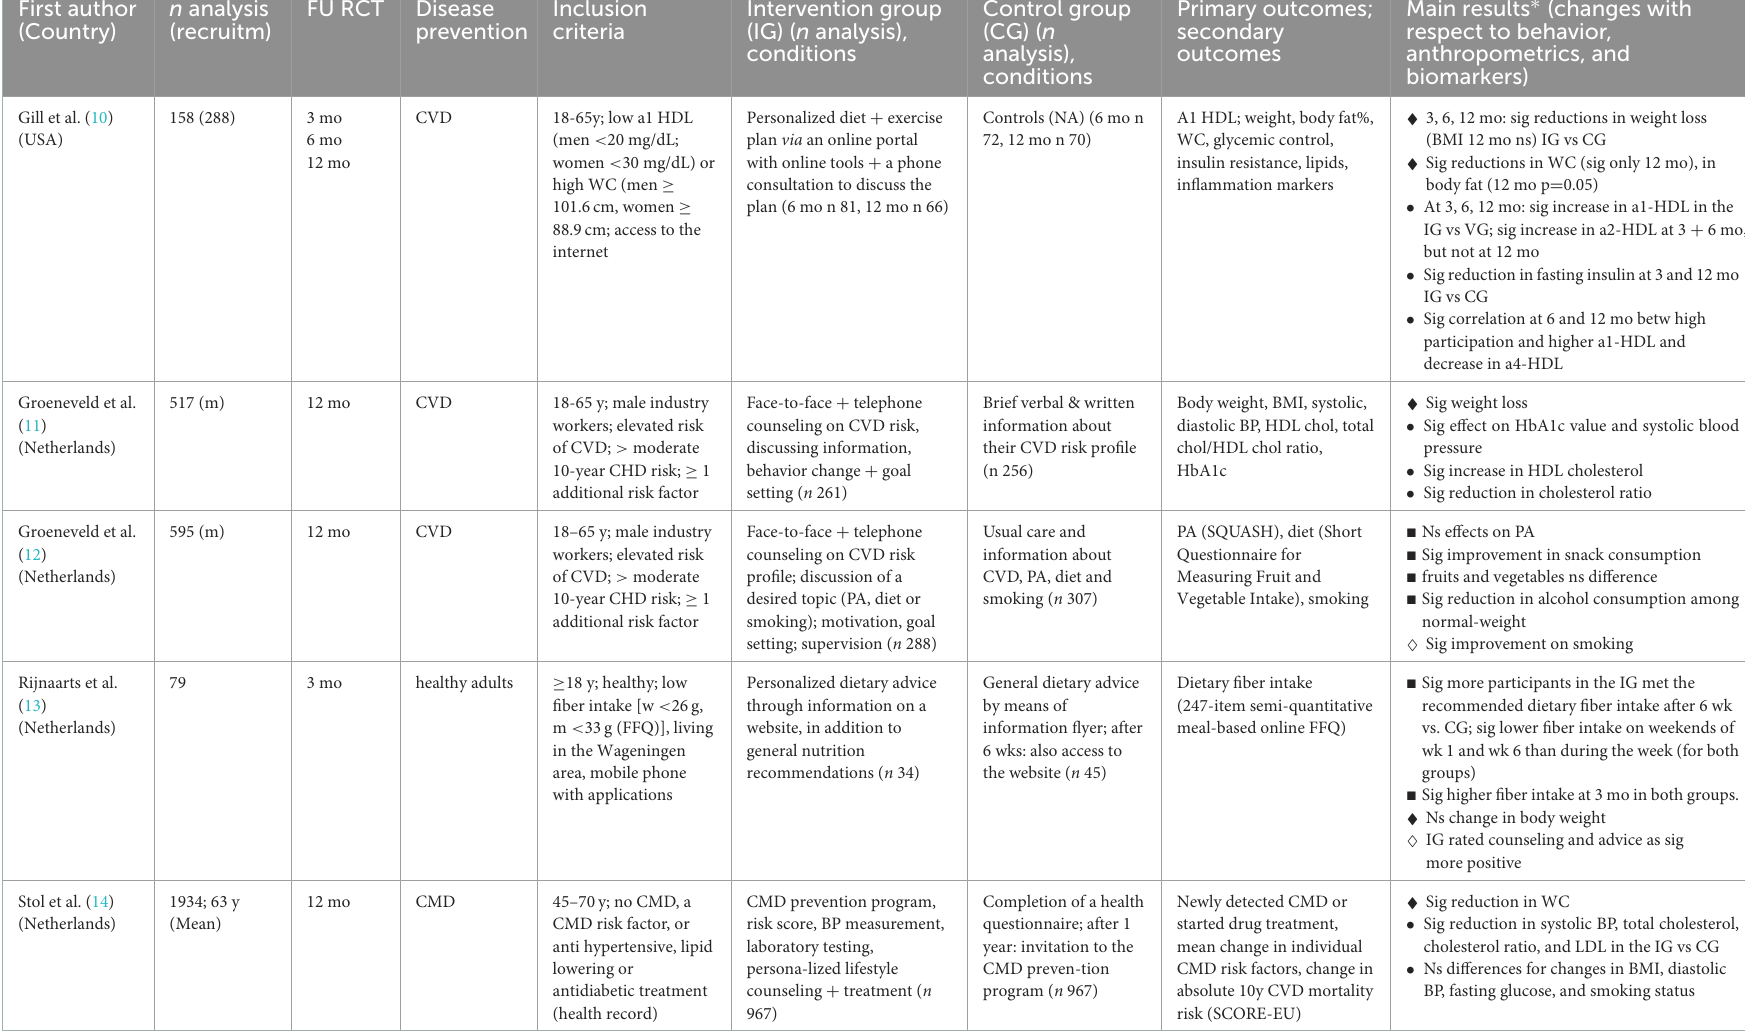
TABLE 1 Effects of personalized prevention based on current diet, physical activity or risk assessment on behavior, anthropometrics and biomarkers – An overview of